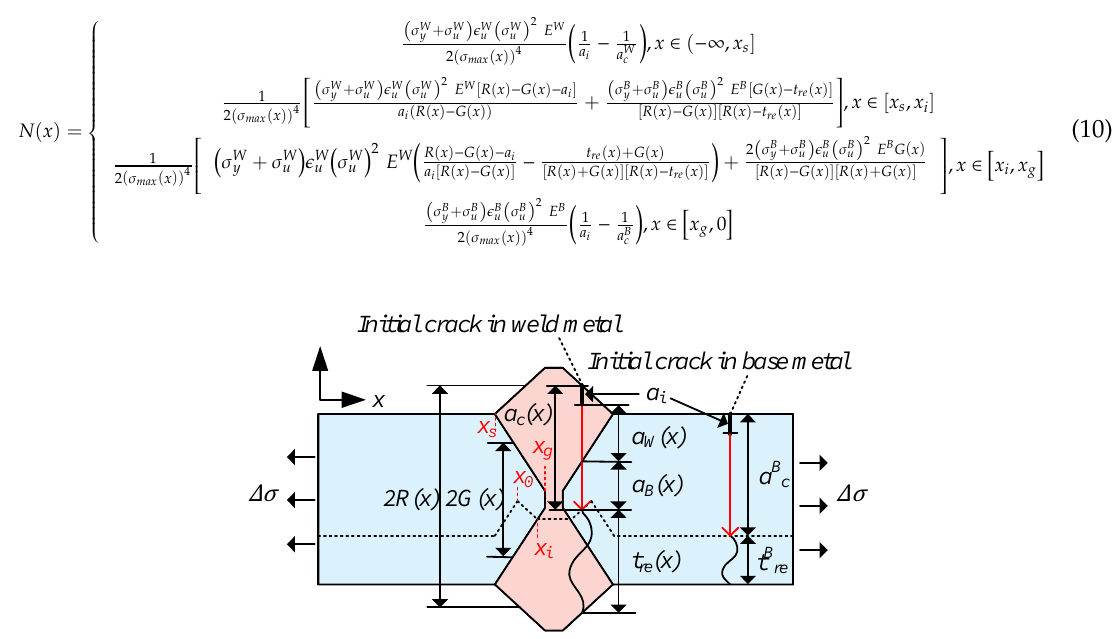
Figure 4. Simplified model of double Y-groove butt-welded joints.